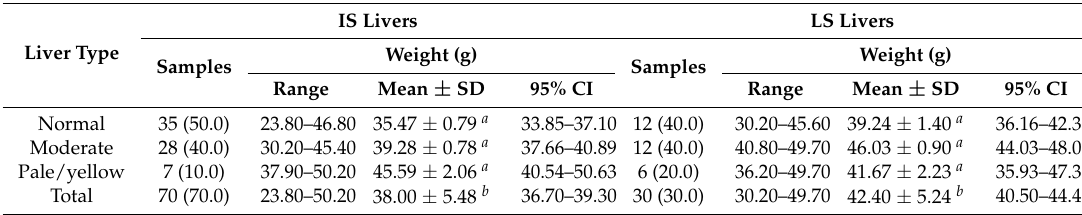
Table 1. Morphological evaluation of liver samples.